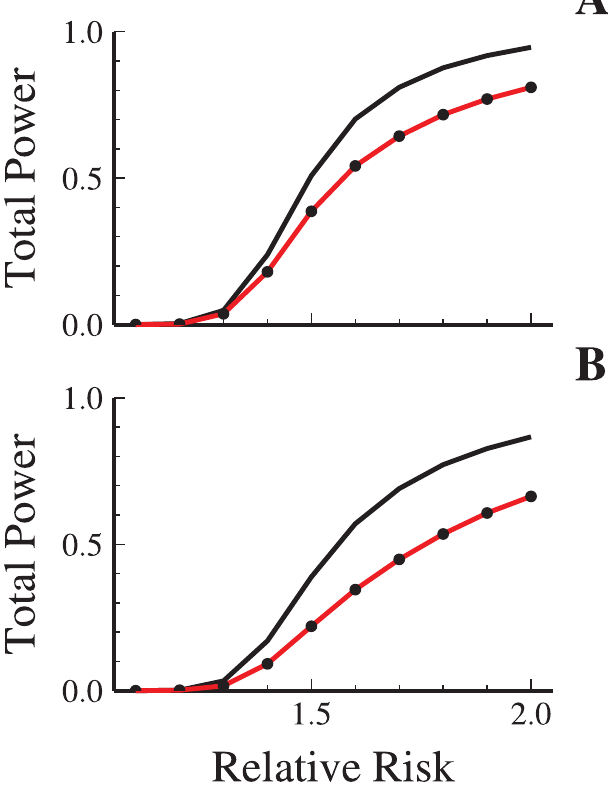
Figure 4. Total Power to Detect a Single Common Risk Allele outside of the HapMap Data Using 1,000 cases and 1,000 Controls under a Multiplicative Model The power is estimated using the common SNPs in 68 resequenced SeatleSNPs genes that were not characterized in the HapMap Project for (A) 23 CEU samples using HumanHap550 and (B) 24 YRI samples using HumanHap650Y. Power is calculated for a 5% false discovery rate after a Bonferroni correction for multiple testing (red line). The solid black line shows the power to detect a common risk allele in the HapMap data (i.e., solid red lines in Figure 2).